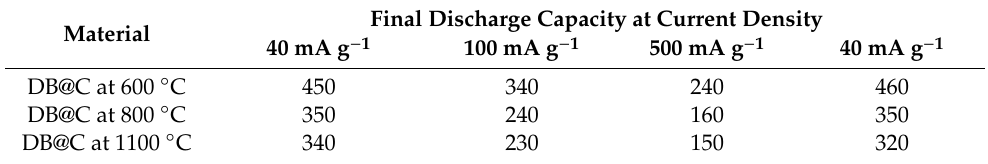
Table 4. Summarized data of the final discharge capacity at di ff erent current